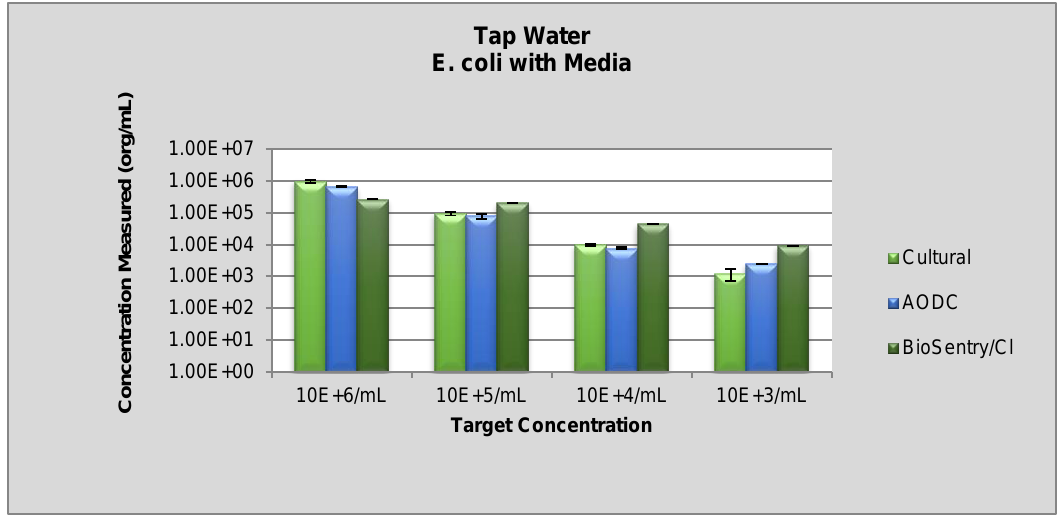
Figure 2. The sensor A response to E. coli in tap water.